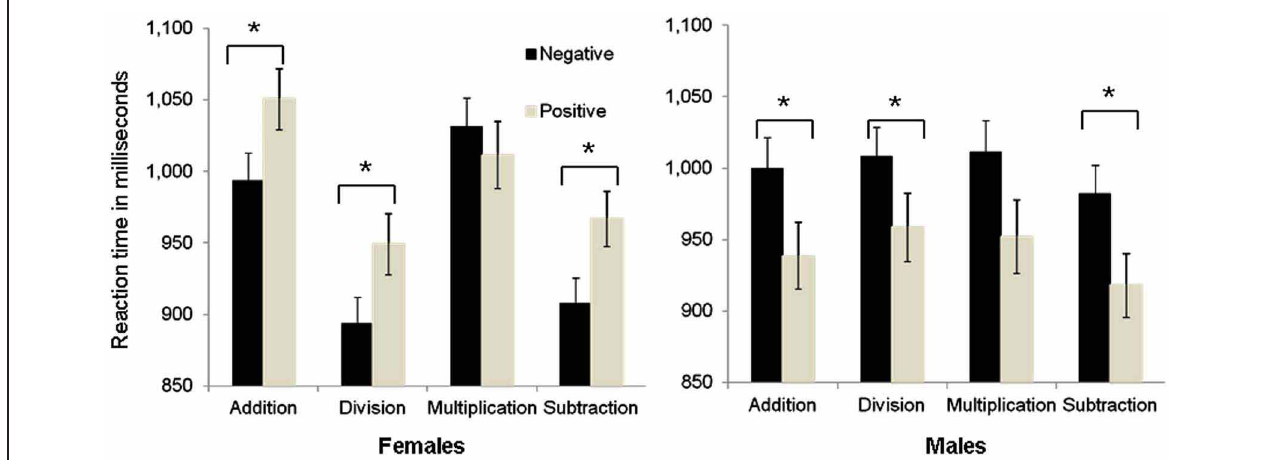
FIGURE 1 | Triple interaction between Prime (negative vs. positive), Arithmetic Procedure and Group. Planned comparisons revealed an affective priming effect (i.e., positive affective primes vs. negative affective primes) in both groups but with a different pattern. Error bars denote the standard error of the mean. ∗ = ( p < 0 . 05 )